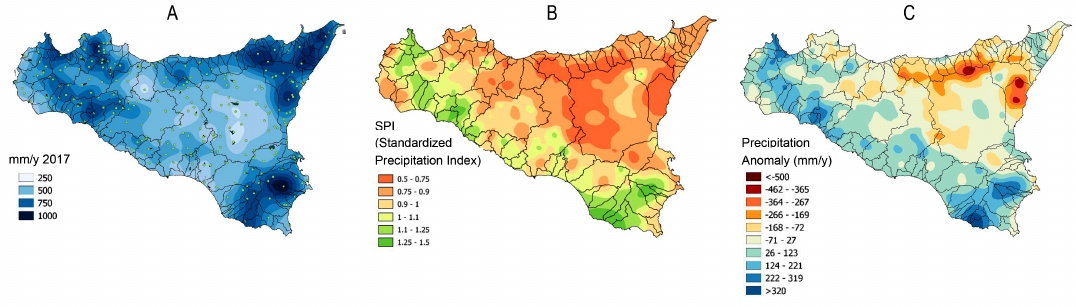
Figure 4. ( A ) Precipitation 2017 (mm/year); ( B ) standard Precipitation Index classes; ( C ) Precipitation anomaly